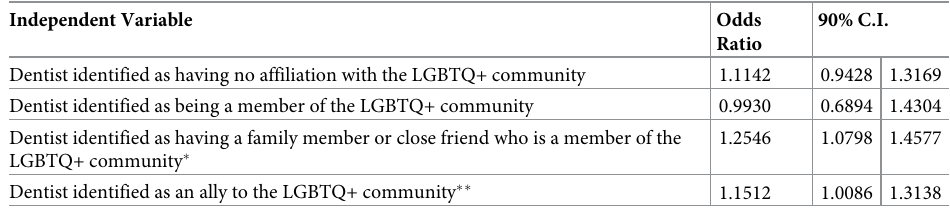
Table 4. Independent Variable Odds Dentist identified as having no affiliation with the LGBTQ+ community 1.1142 0.9428 1.3169 Dentist identified as being a member of the LGBTQ+ community 0.9930 0.6894 1.4304 Dentist identified as having a family member or close friend who is a member of the LGBTQ+ community � Dentist identified as an ally to the LGBTQ+ community �� 1.1512 1.0086 1.3138 Odds ratios (OR)s and 90% confidence intervals (CI)s calculated from logistic regression model � P < 0.05 �� P <